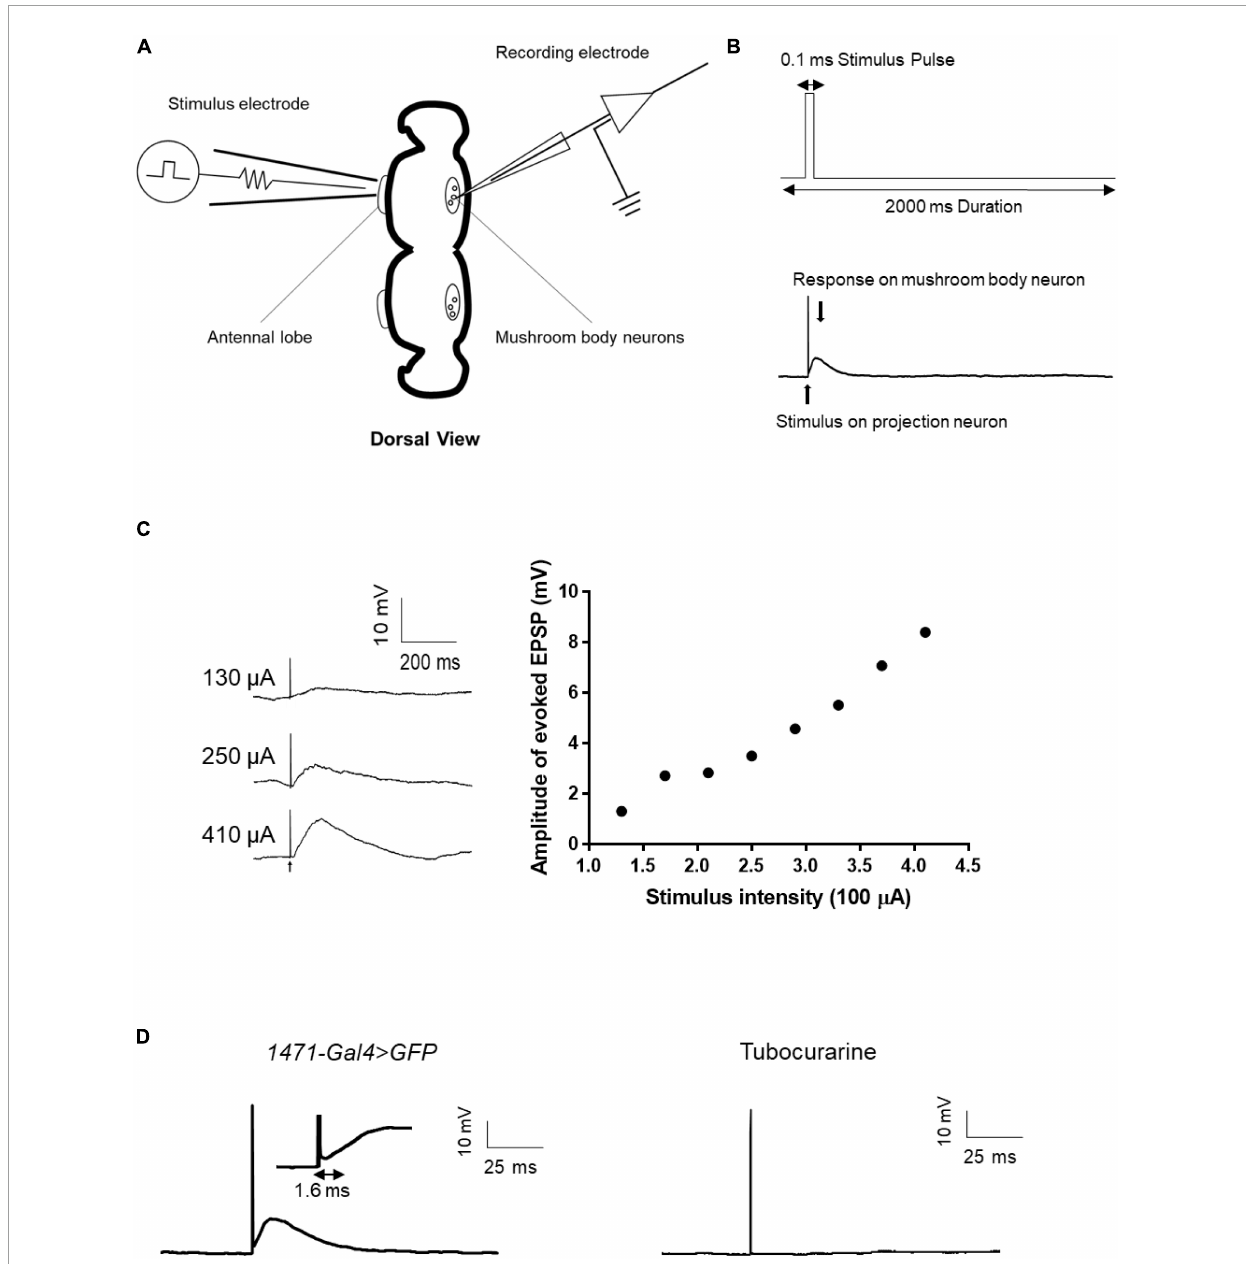
FIGURE6 Evoked EPSP recording in the fly brain. (A) Scheme of evoked EPSP recording between the antennal lobe and mushroom body. The stimulation electrode attached to the antennal lobe and recording electrode was used to record evoked EPSP in mushroom body neurons. (B) Stimulus protocol for the stimulation electrode is shown in the upward picture. Stimulus artifact and response signal are shown in the downward picture. (C) Typical trace of evoked EPSP in different stimulus intensities and the input-output curve of evoked EPSP. (D) Latency time of evoked EPSP in gamma neuron. Tubocurarine confirmed that the evoked EPSP is